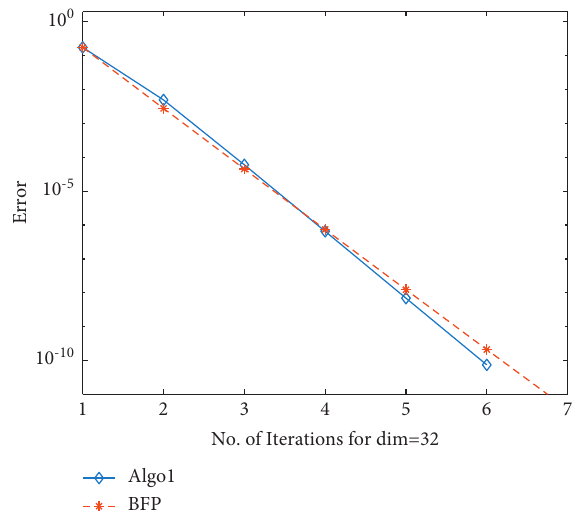
Figure 21: Iteration no. vs error for dimension